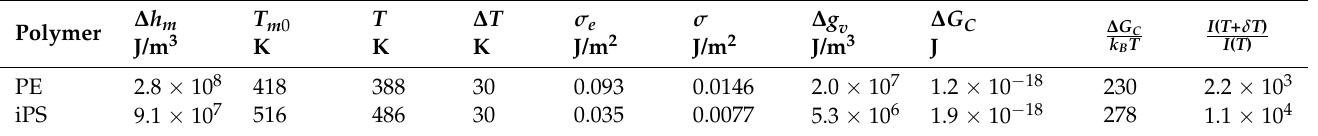
in PE and iPS at δ T = − 0.5 K. I ( T )